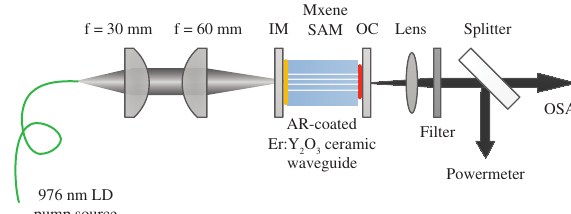
O ceramic channel waveguide laser 2 3